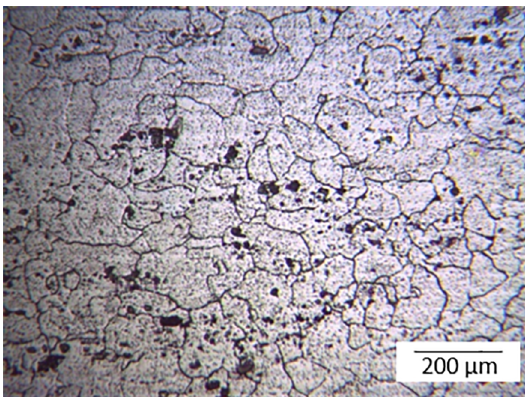
Figure 3. MO image in the rolling direction of the AA5083-O chemical etched, the rolling plane is parallel to the page and the rolling direction is horizontal to the